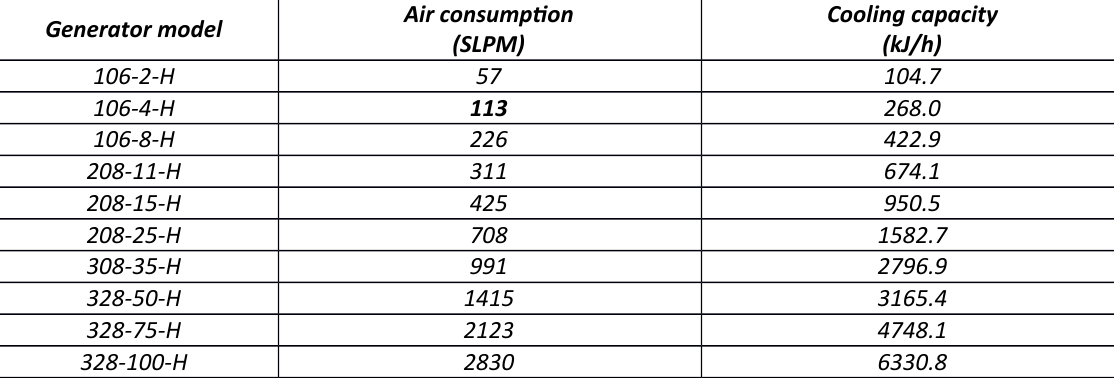
Table 1. Compressed air consumption (in standard liters per minute) and cooling capacity for different vortex generators (6.9 bar inlet pressure)